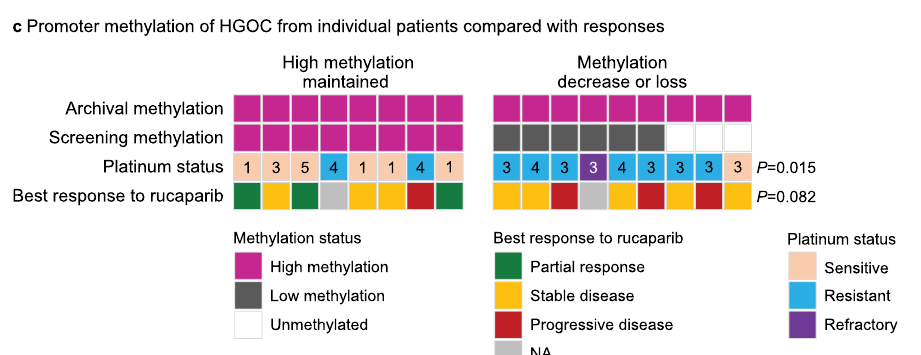
Fig. 3 High BRCA1 methylation levels at screening are associated with better outcomes. a Kaplan – Meier plot showing PFS in ARIEL2 patients with BRCA wt HGOC having high (magenta), low (blue), or no methylation (unmethylated, teal) in archival biopsy. b Kaplan – Meier plot showing PFS in ARIEL2 patients with BRCA wt HGOC having high (magenta), low (blue), or no methylation (unmethylated, green) in screening biopsy. P values in panels a and b are based on Cox proportional hazard model. c Methylation status at screening as compared to the archival sample, platinum status, and best response to rucaparib of 17 HGOC with high BRCA1 methylation levels in the archival sample and an available matched screening biopsy; numbers indicate number prior lines of chemotherapy treatment; P values are based on a two-sided Fisher ’ s exact test testing the proportion of patients with platinum status of sensitive and best response of partial response between HGOC that maintained methylation vs decrease or loss of methylation. BRCA BRCA1 or BRCA2 , CI con fi dence interval, HGOC high-grade ovarian carcinoma, HR hazard ratio, NA not applicable, PFS progression-free survival, wt wild